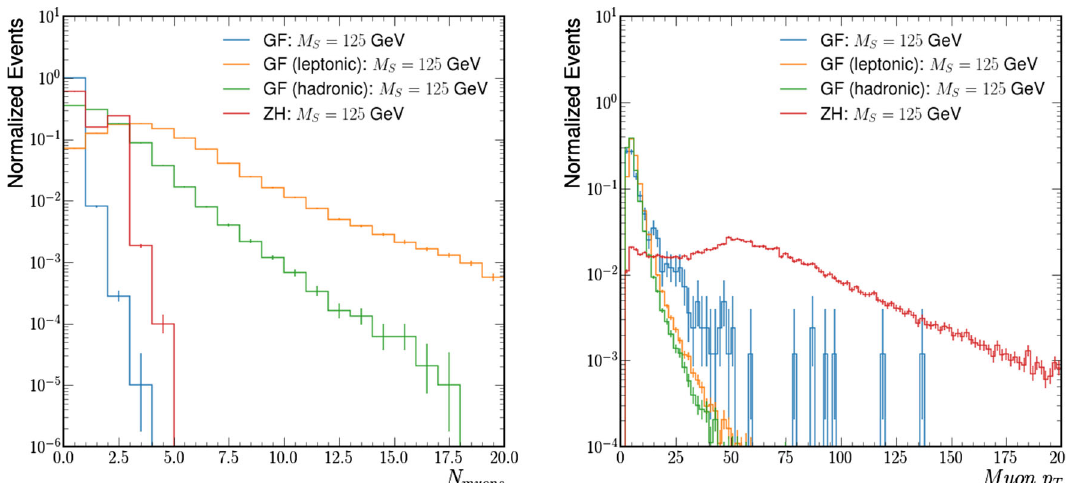
Fig. 19 ThenumberofmuonsatthegeneratorlevelfordifferentSUEP production mechanisms and dark photon decay branching fractions is shown on the left. Muons are selected with p T > 3 GeV and | η | < 2 . 5.